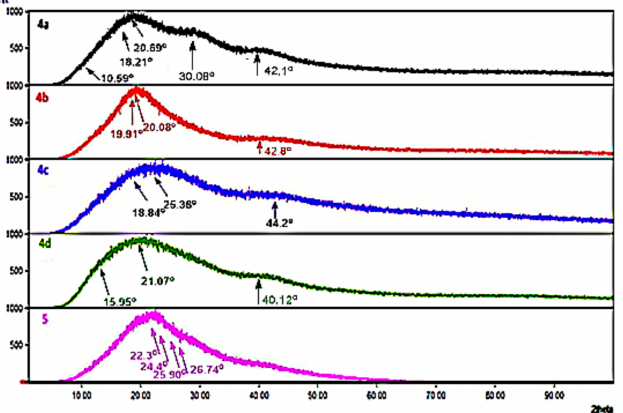
Figure 3. XRD patterns of 4a, 4b, 4c, 4d , and 5 phenolic